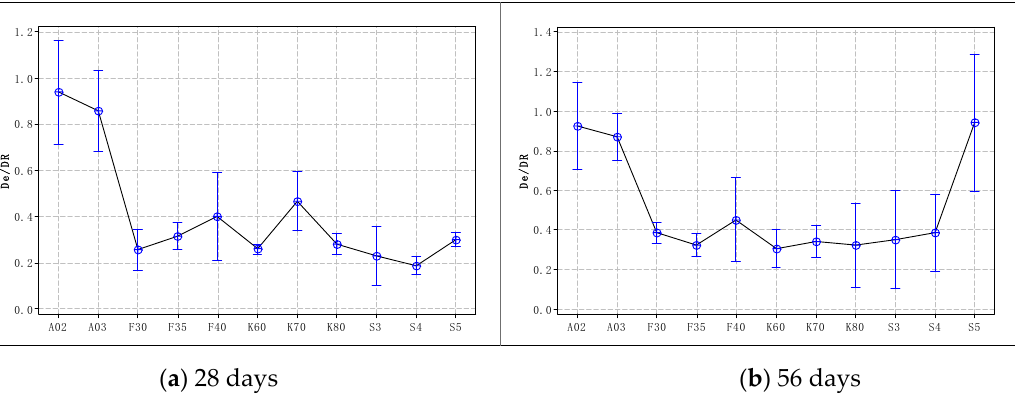
Figure 5. Ratios of diffusion coefficients of 28 and 56 days.